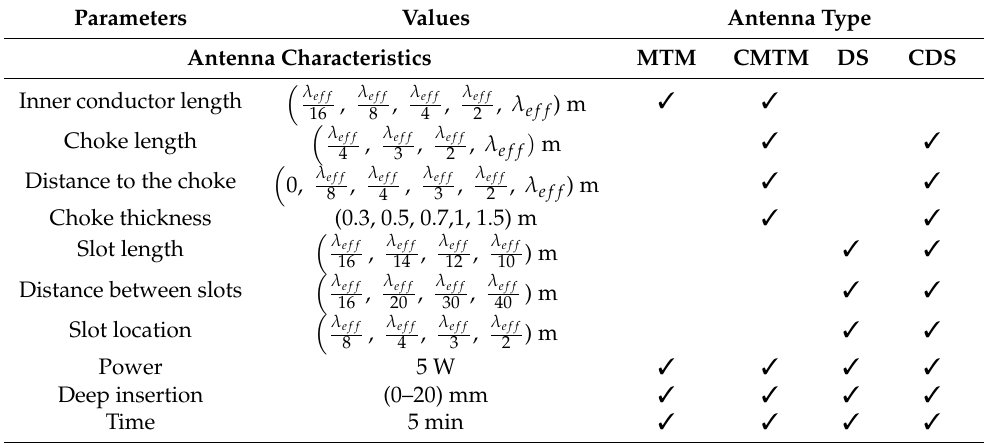
Table 2. Parameters used for the implementation of the parametric study to optimize each